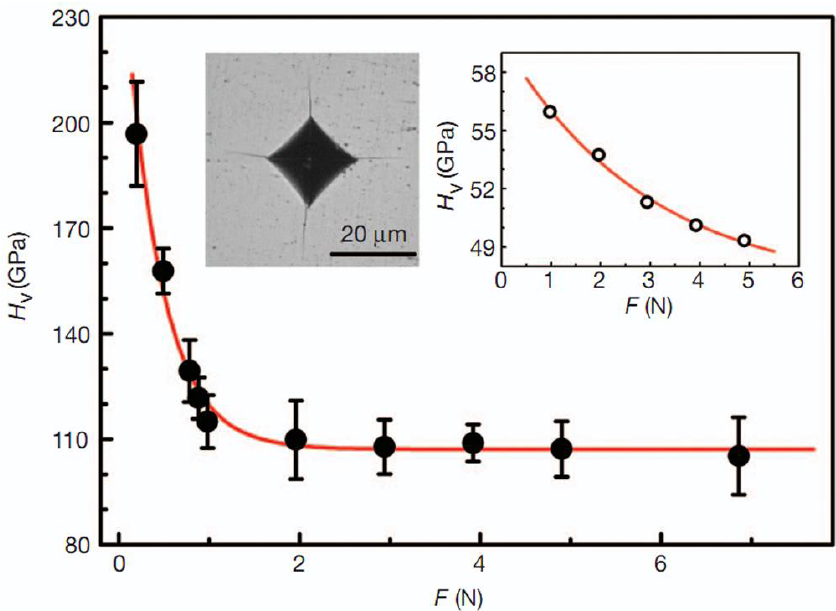
Figure 6. The H V of an nt-cBN bulk sample as a function of applied load (F). The H V of the nt-cBN bulk decreases from ∼ 196 GPa at 0.2 N to its asymptotic value, 108 GPa, beyond 3 N. Error bars indicate s.d. ( n = 5). Left inset, an optical micrograph of the Vickers indentation with cracks produced at a load of 19.6 N. Right inset, the H V –F curve of a 0.3 mm cBN single crystal. H V does not reach its asymptotic value, and the crystal fractures when F exceeds 4.9 N. Reprinted with permission from Tian et al., Nature 493 , 385 (2013). Copyright 2013 Nature Publishing Group (Ref. 7).